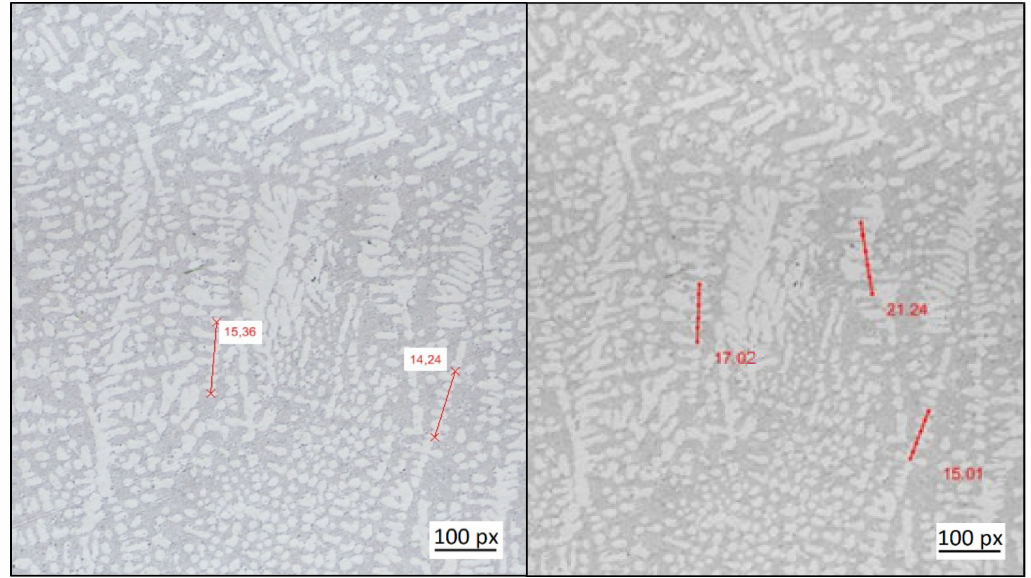
Figure 6. Comparison of manual (left)–and automated (right) dendrite measurements exemplified for structure